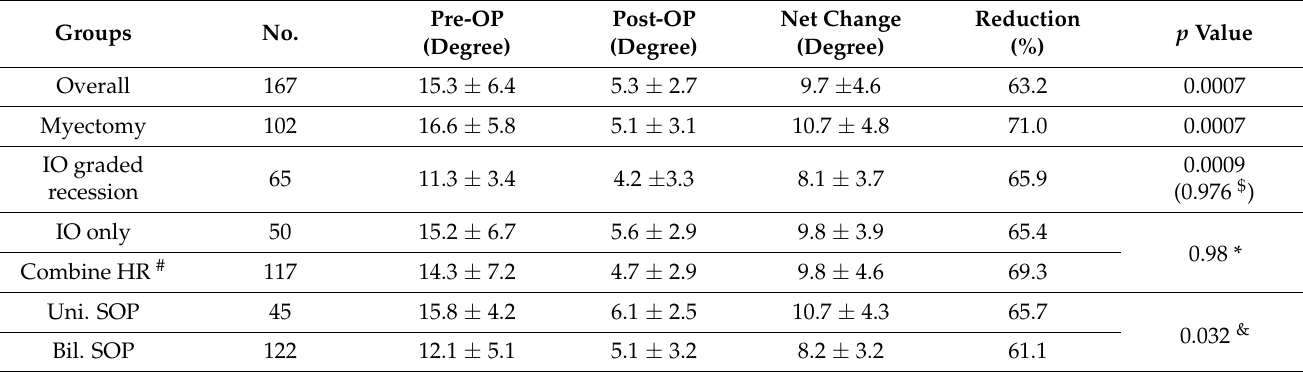
Table 2. The preoperative and postoperative degrees of ocular torsion.